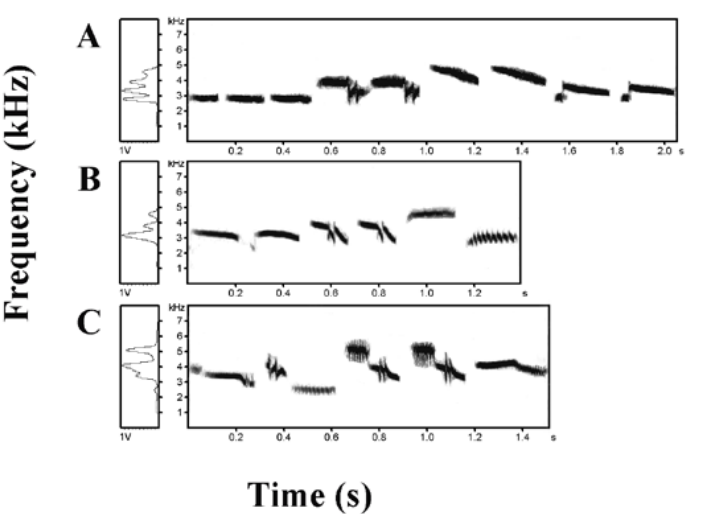
Figure 4. The typical song of each subspecies. ( A ) is from E. a. aureola , ( B ) is from E. a. ornata and ( C ) is from E. a. insulana .